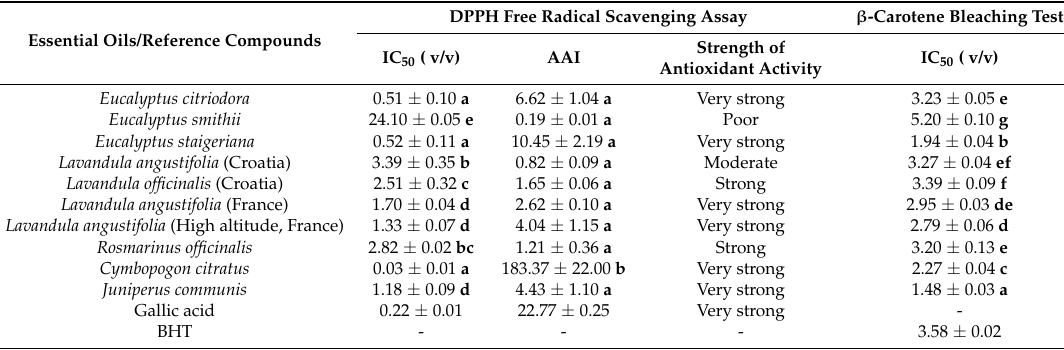
Table 5. Antioxidant properties of the EOs measured by two different